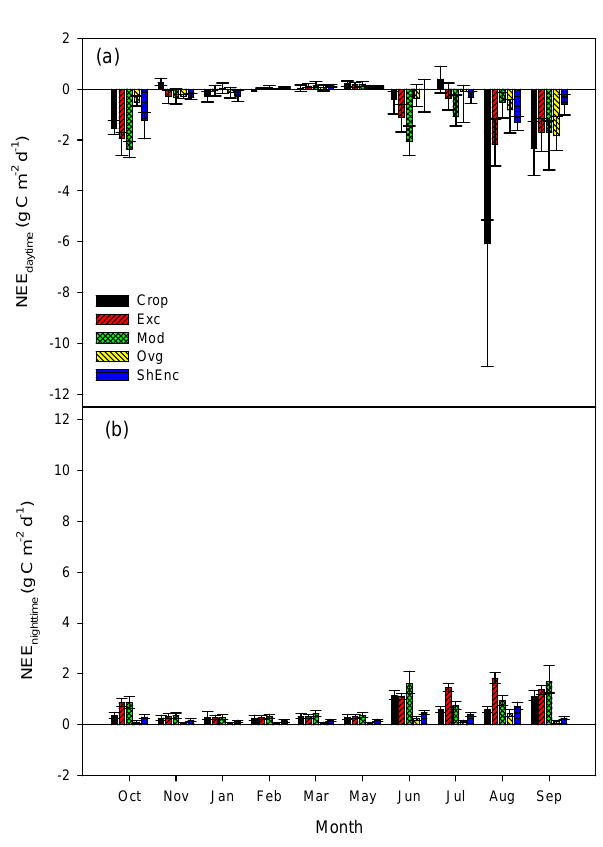
Fig. 3. Daily daytime (a) and nighttime (b) NEE (mean ± 1CI) at five sites with contrasting land use types in the shortgrass steppe from central Mexico, recorded from October 2008 to September 2009. For explanation of acronyms, please refer to Fig. 2